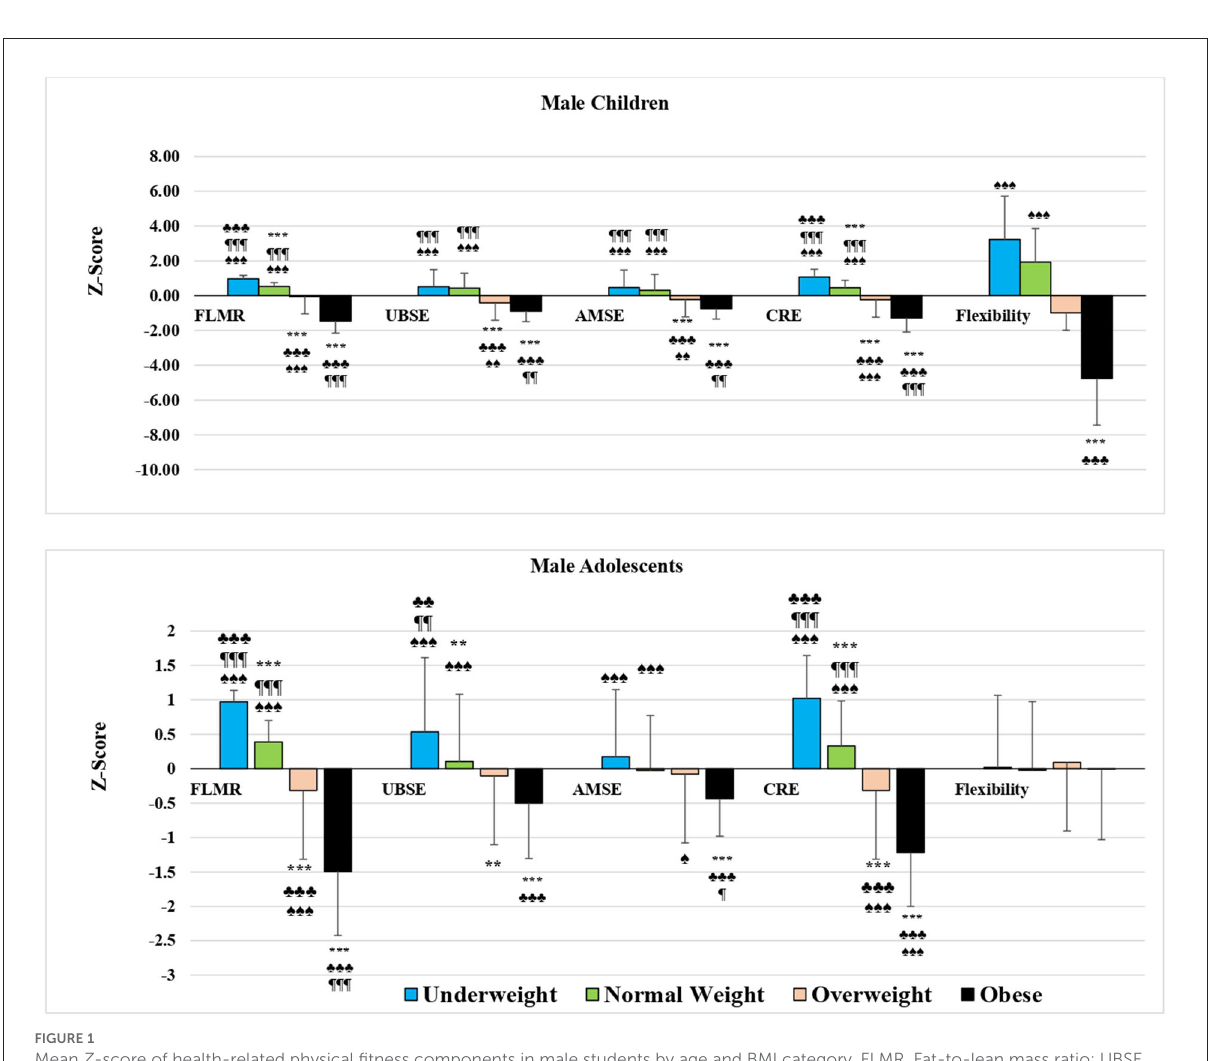
FIGURE1 Mean Z -score of health-related physical fitness components in male students by age and BMI category. FLMR, Fat-to-lean mass ratio; UBSE, Upper body strength and endurance; AMSE, Abdominal muscular strength and endurance; CRE, Cardio-respiratory endurance. * p < 0.05, ** p